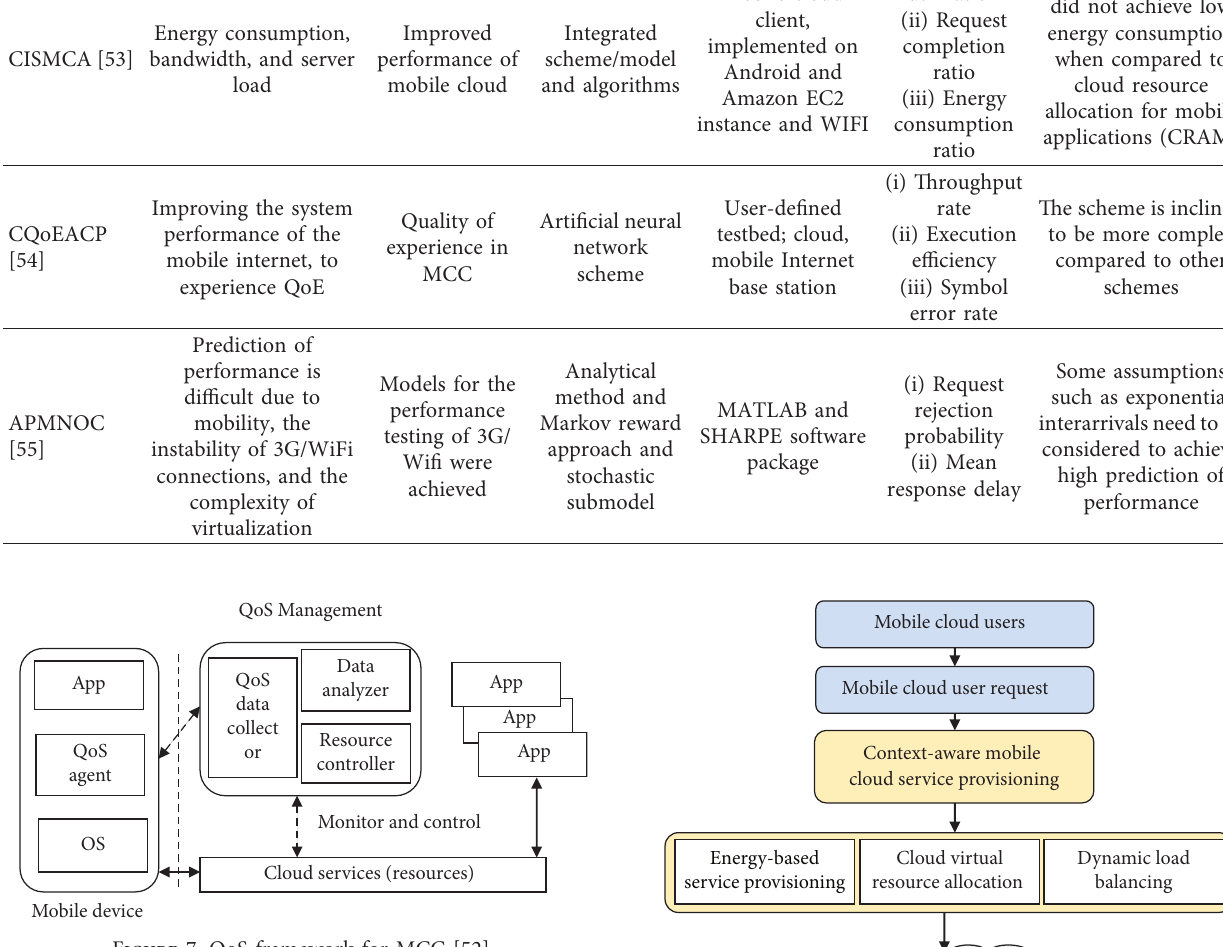
Figure 7: QoS framework for MCC [52].